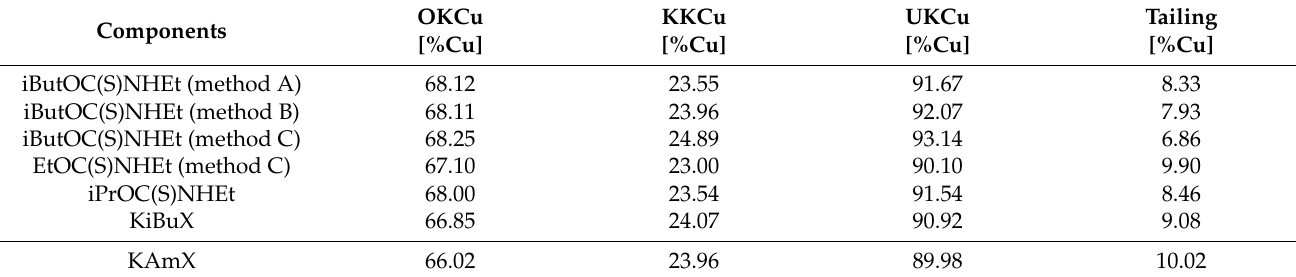
Table 4. Flotation results obtained using synthesized compound, N -alkyl- O -isobutyl thiocarbamate (Methods A, B, and C) sample of real ore (Elacite, Bulgaria) at the laboratory level (copper content in ore, 1.8515%; OKCu, basic flotation